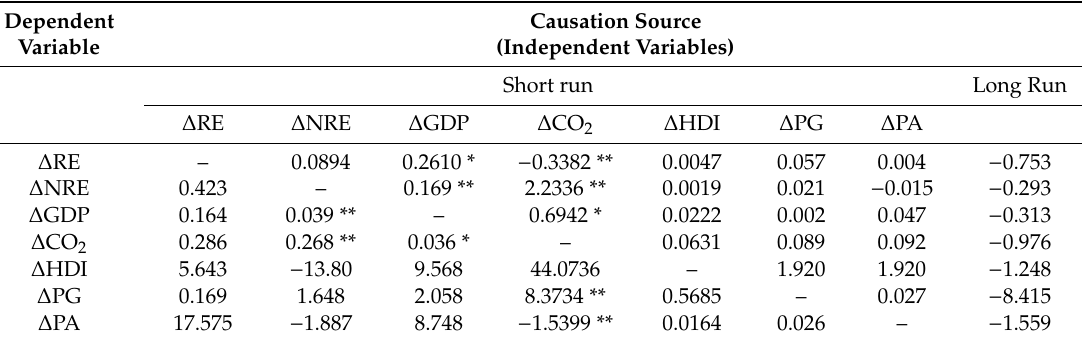
Table 8. VECM and Granger causality